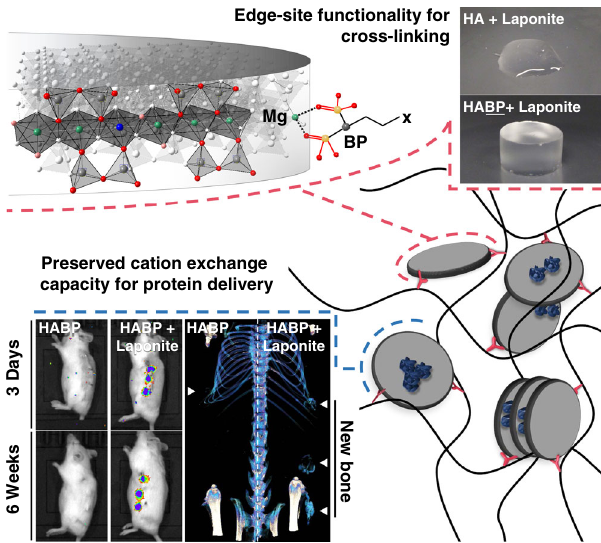
Fig. 7 Clay – bisphosphonate complexation for dual